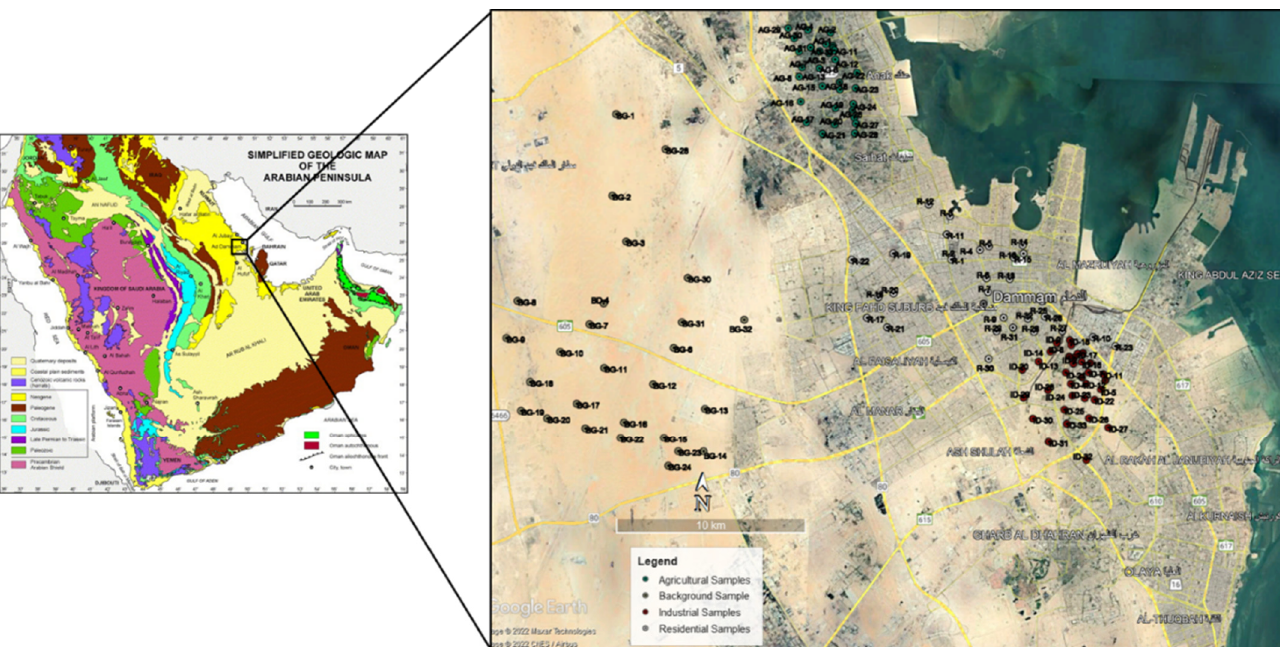
Figure 2. Sample locations used in the current study.